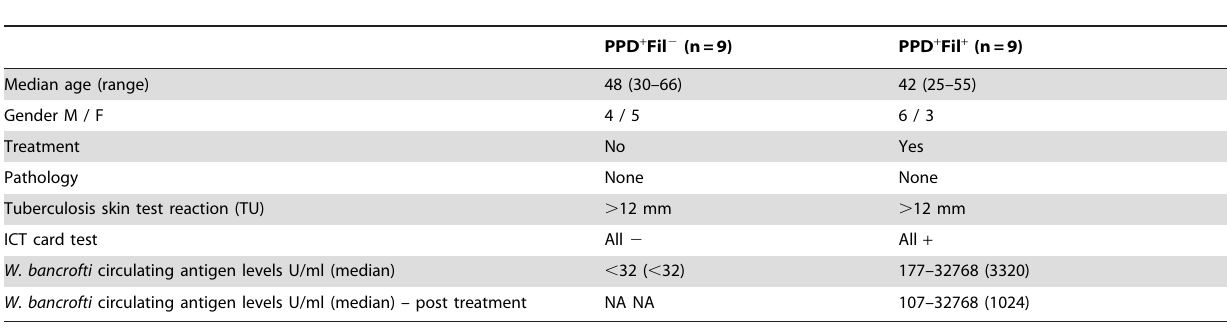
Table 1. Characteristics of the study